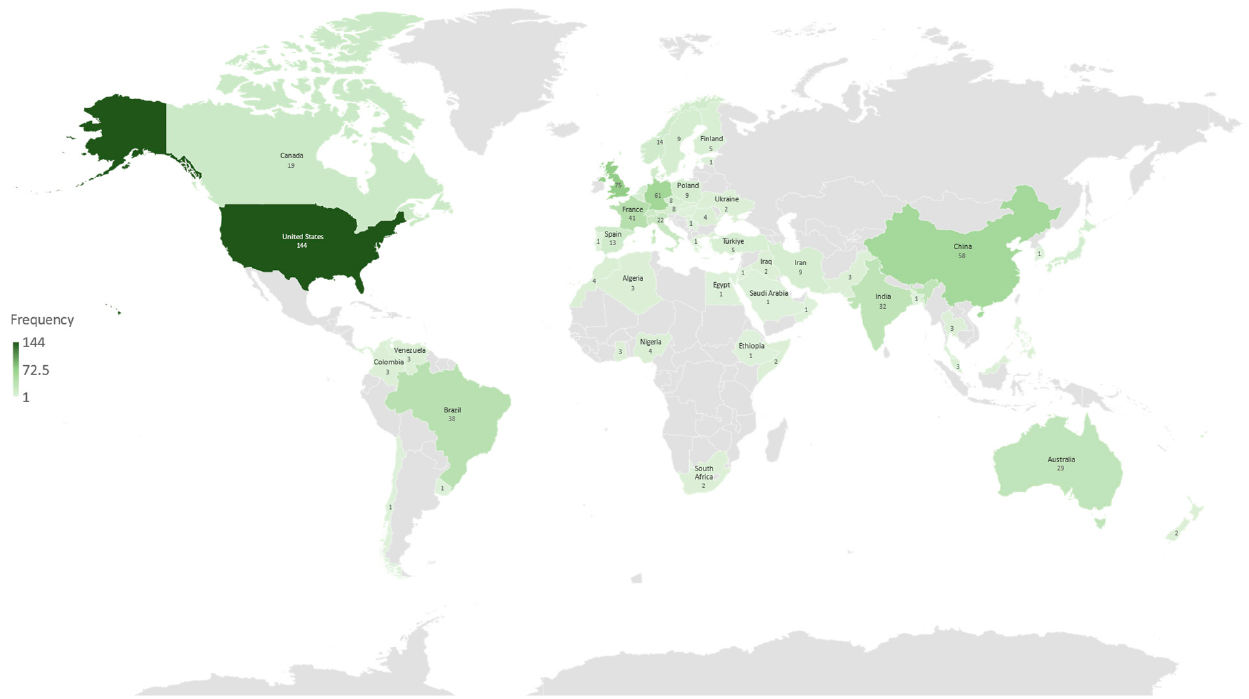
Figure 4. Distribution of the affiliation of the authors of the analyzed documents.